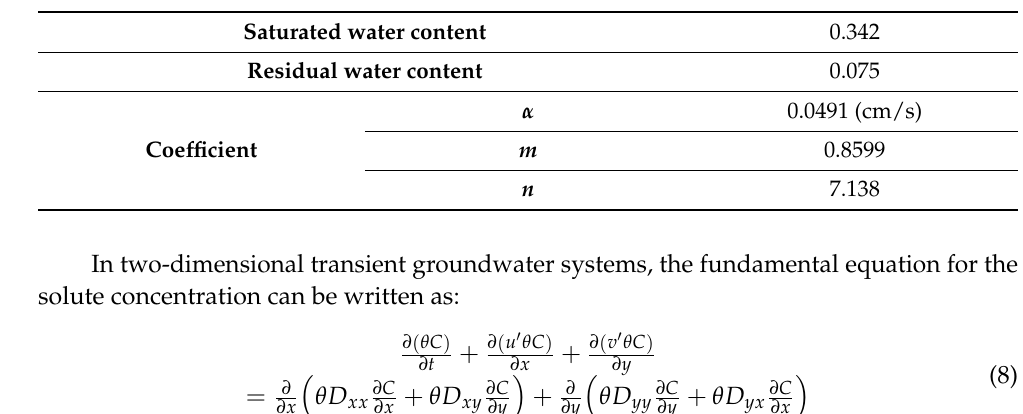
Table 2. Parameters for van Genuchten